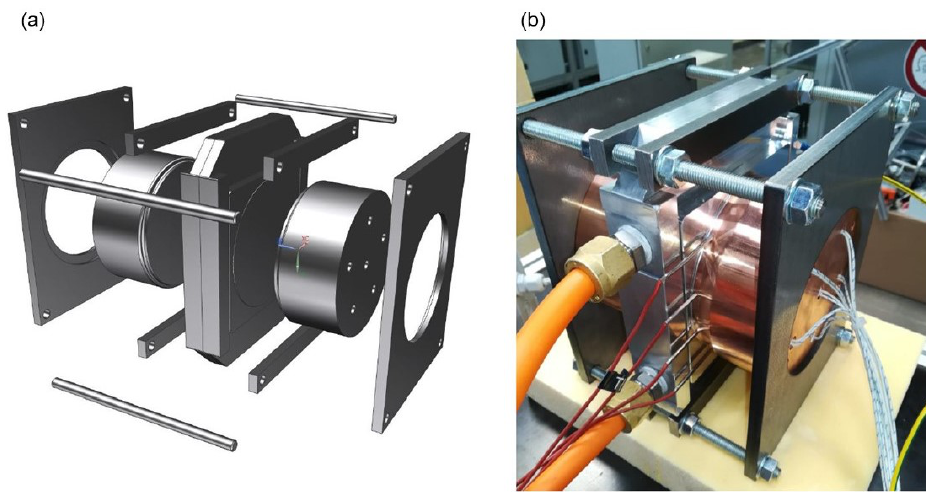
Figure 2. ( a ) An explosion view of the heat sink and heating blocks used in this investigation and ( b ) a photograph of the heat sink and heating blocks used in the experimental investigation. Table 3. Technical and geometric data for the heat sink used in this experimental investigation. Material of the Heat Sink AlMgSiO 5 Thermal conductivity of the heat sink material ( λ